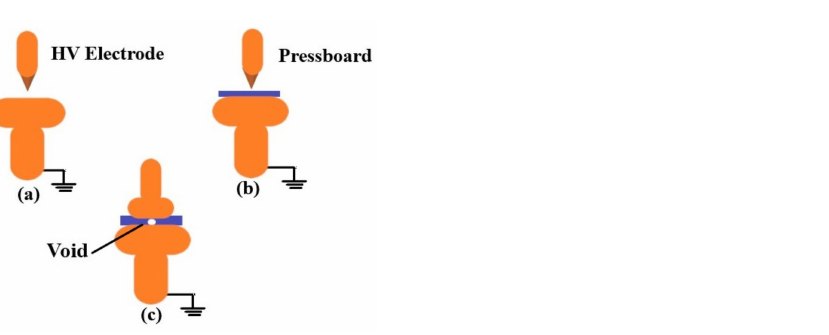
Figure 1. Overall Experimental Setup.